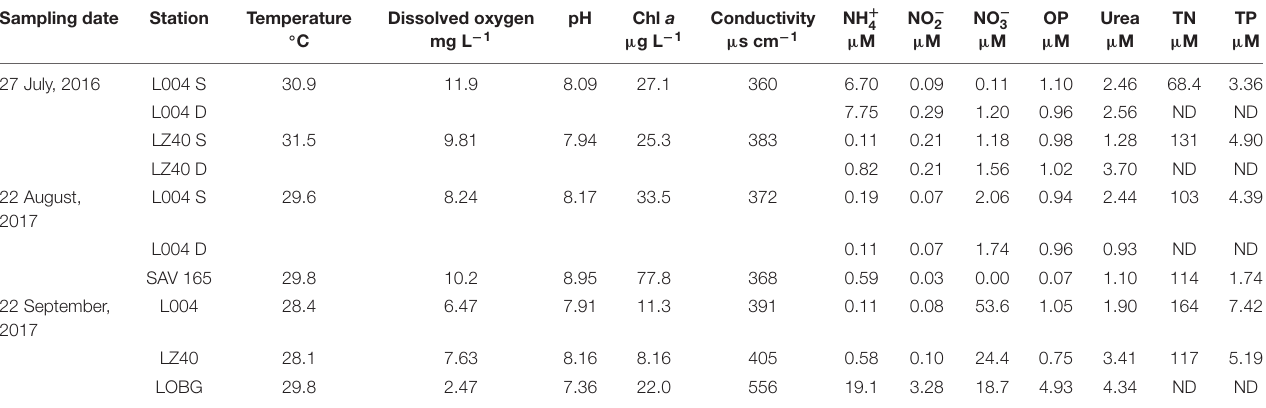
TABLE 1 | Environmental data and ambient nutrient concentrations in Lake